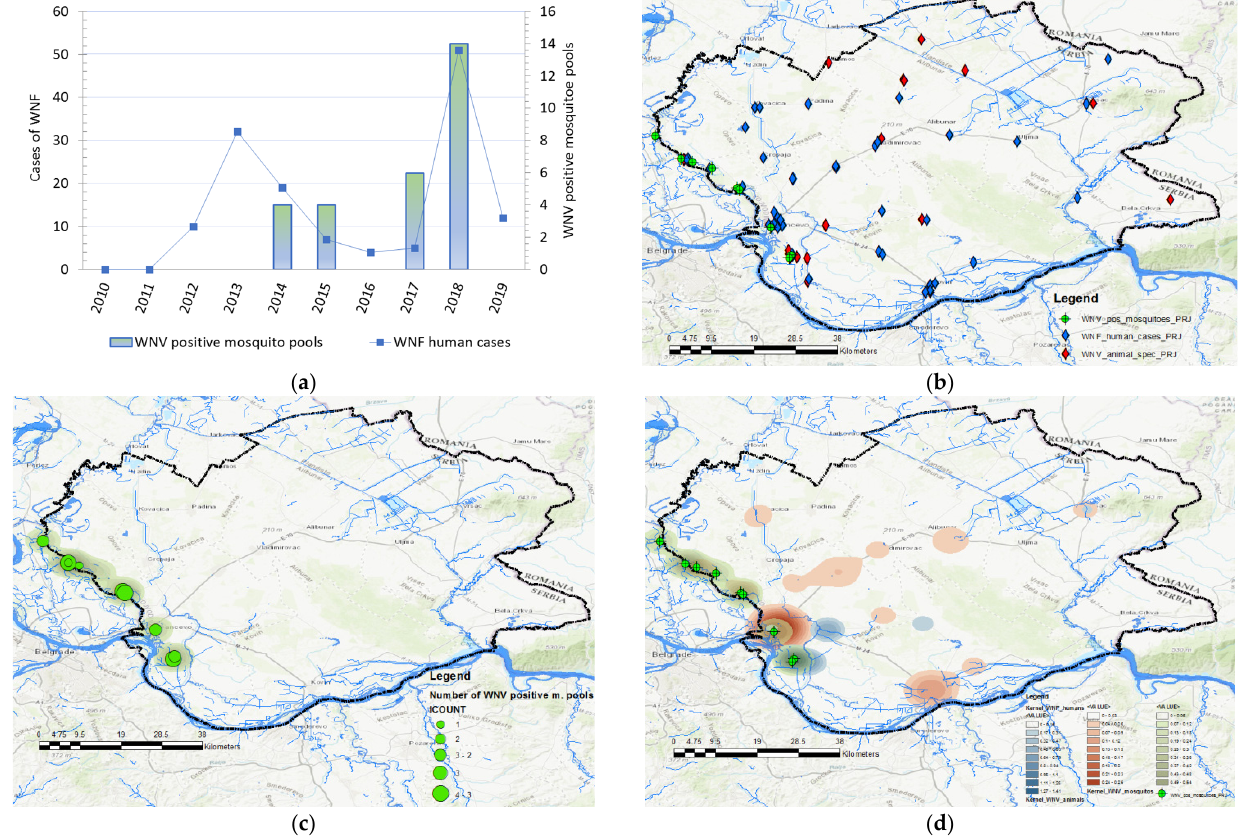
Figure 4. Distribution and abundance of the West Nile virus (WNV) human cases and WNV-positive mosquito pools: ( a ) Frequency distribution of human cases of WNV infection, and WNV-positive mosquito pools in 2014, 2015, 2017, and 2018; ( b ) distribution of registered cases of WNV infection in humans (blue), domestic animals (red), in 2017, 2018, and 2019 and mosquitoes (green) in 2017 and 2018; ( c ) geographical distribution and abundance of the WNV-positive mosquito pools in 2017 and 2018; ( d ) overlay of kernel density clusters of WNV in humans (red), domestic animals (pink), and clusters of WNV-positive mosquitos (blue).